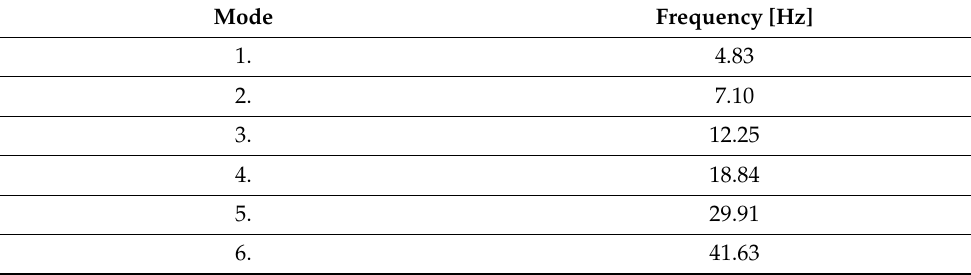
Table 2. Natural frequencies of the fully-extended configuration.